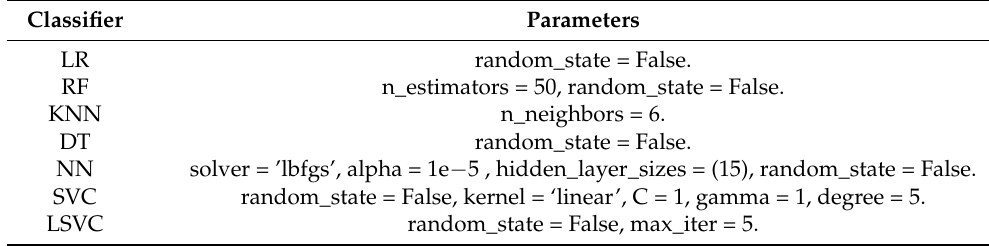
Table 3. Classification algorithms parameters.